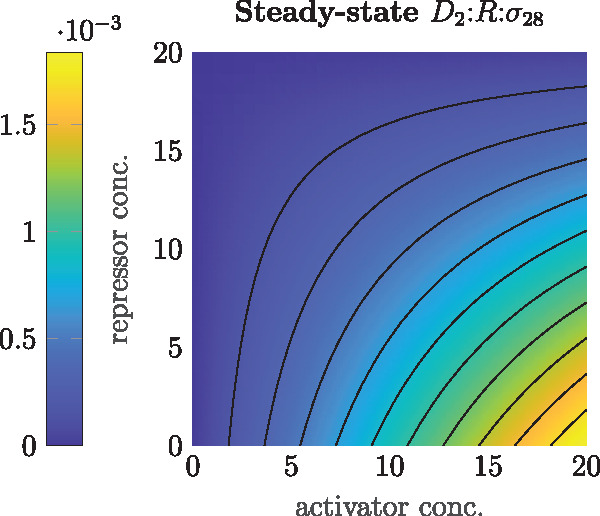
Promoter activity of pTar-tetO, obtained from fitted model.